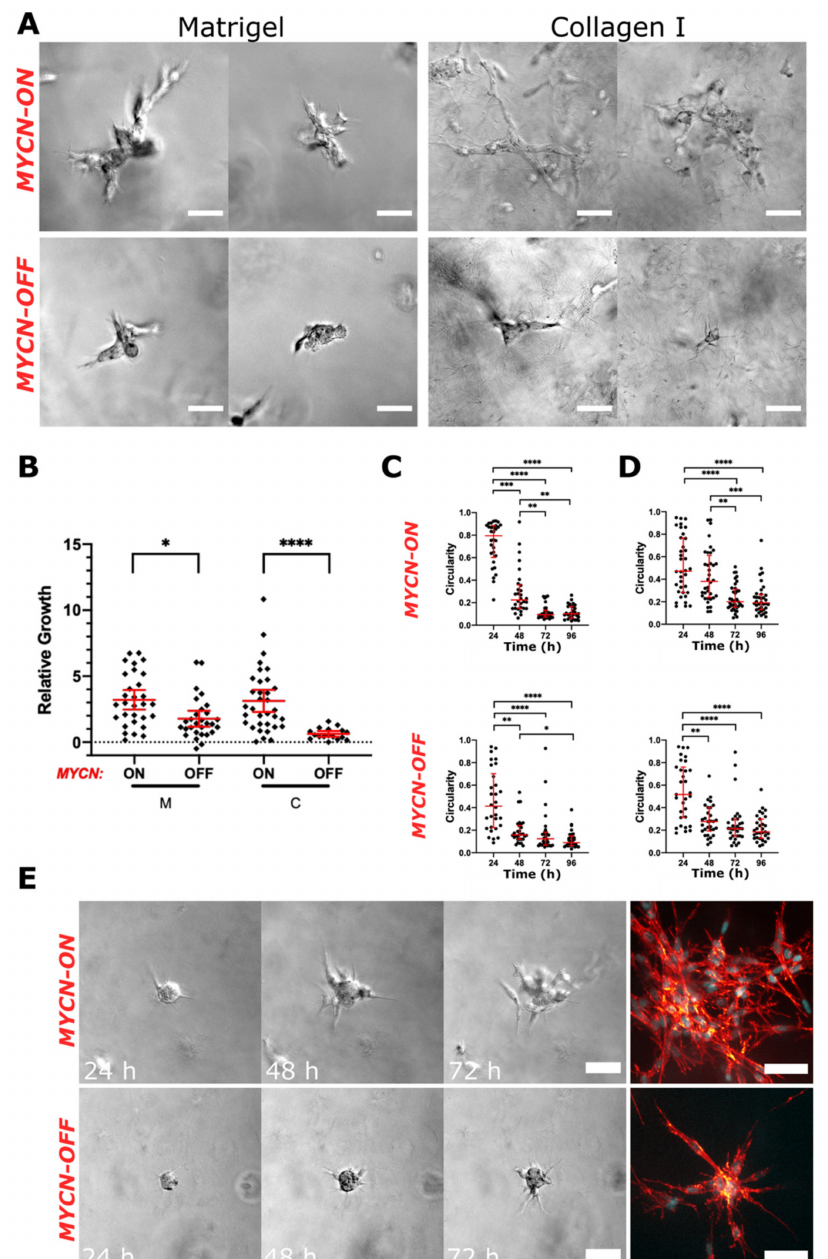
Figure 5. Repressing MYCN expression promotes less aggressive cell behaviour in SHEP-Tet21N cells. ( A ) Representative DIC images of untreated SHEP-Tet21N ( MYCN -ON) and doxycycline-treated ( MYCN -OFF) cells after 72 h in Matrigel and collagen. ( B ) Relative growth of organoids was calculated by dividing the difference in cluster area at 72 h compared to 24 h, by the area at 24 h (Brown–Forsythe ANOVA with T3 Dunnett post-hoc tests; horizontal bars represent mean ± 95% confidence intervals). Circularity of MYCN -ON and MYCN -OFF cell clusters was measured at 72 h in Matrigel ( C ) and collagen ( D ) (Kruskal–Wallis and Dunn’s post-hoc tests; horizontal bars represent median and interquartile range). ( E ) Representative DIC time-lapse and confocal micrographs (120 h) comparing SHEP-Tet21N cell clusters with MYCN -ON and MYCN -OFF; nuclei stained with DAPI (cyan) and F-actin stained with phalloidin (red). In all plots, each dot represents one cell cluster ( MYCN -ON; n = 30 in Matrigel, n = 34 in collagen. MYCN -OFF; n = 29 in Matrigel, n = 17 in collagen) and asterisks indicate statistical significance (* p < 0.05, ** p < 0.01, *** p < 0.001, **** p < 0.0001). Scale bars = 50 µ